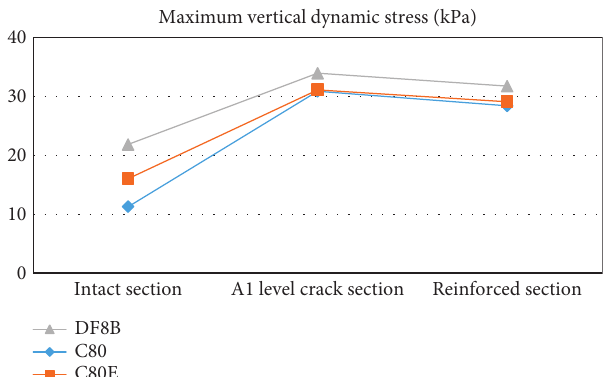
Figure 25: Comparative analysis of maximum vertical dynamic stress on top surface of filling layer between two